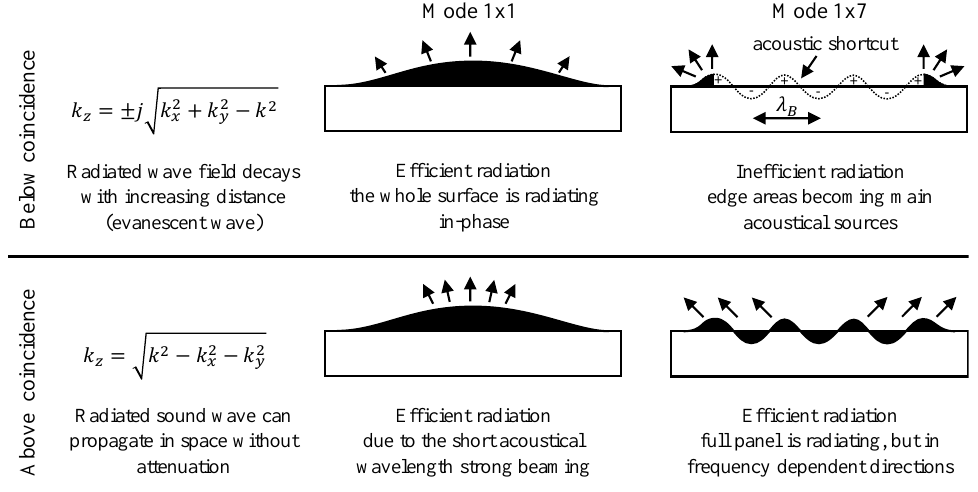
Figure 3. Theoretical comparison of the radiation behavior below and above the coincidence of two different mode shapes. If a mode shape with nodal lines occurs, the coupling to the air depends on the ratio of the bending wavelength λ B to the acoustic wavelength λ A